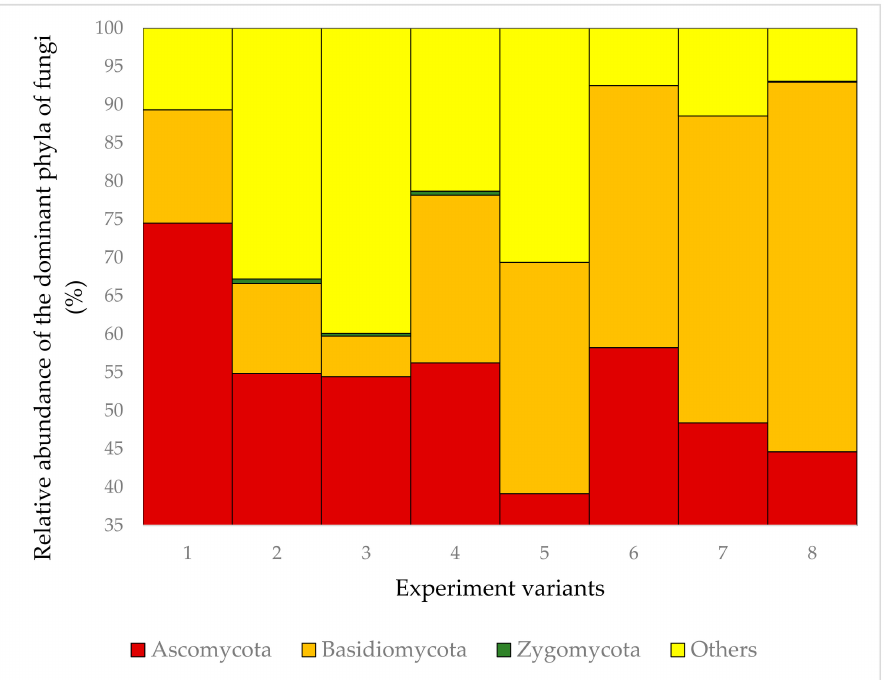
Figure 1. Relative abundance of the dominant phyla of fungi in the 8 experiment